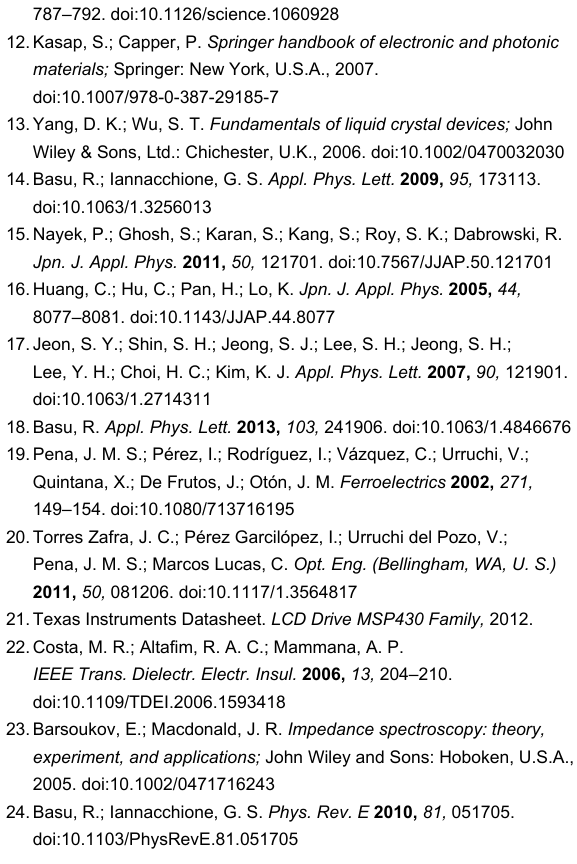
sinusoidal signal of 100 mV rms was added up in all cases, its frequency was varied from 100 Hz up to 10 MHz. The wave- form was programmed in a 1260 Solartron impedance analyzer controlled by a PC that collects data as